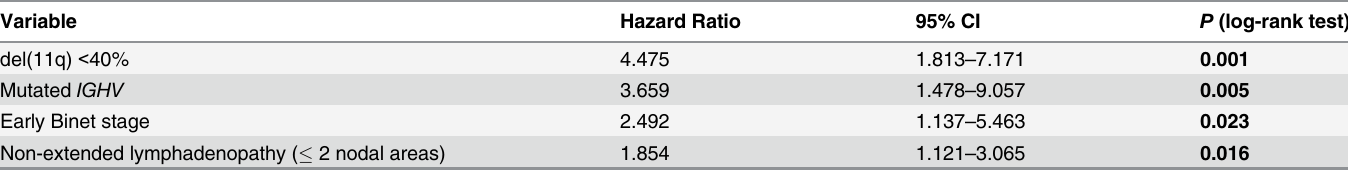
observed in patients with a low frequency of losses in 11q-. Thus, in patients with loss of 11q in (cid:1) 40% of cells, the OS was 90 months (95% CI, 57 – 123 months), while in the group with < 40% of losses in 11q, the median OS had not been reached (95% CI, 114 – 157 months) ( P = 0.006) (Fig 1B). In the univariate analysis, early clinical Binet stage ( P = 0.001), asymptomatic disease ( P = 0.034), absence of hepatomegaly ( P = 0.025) or splenomegaly ( P < 0.0001), lymphocyte count < 20 x 10 9 /L ( P = 0.032), low serum of either LDH level ( P < 0.0001) or β the presence of an association of 11q deletion and 13q deletion ( P = 0.045), and a low number ( < 40%) of cells with 11q- ( P = 0.006) were associated with longer OS (Table C in S1 File). In the multivariate analysis, the variables independently related to longer OS were the absence of splenomegaly (HR, 1.786; P = 0.023), low serum LDH (HR, 2.076; P = 0.018), low serum β (HR, 2.448; P = 0.006) and the presence of del(11q) in < 40% of cells (HR, 3.145; 95% CI, 1.474 – 6.691; P = 0.003) (Table 3). Regarding the patients with del(11q) as the unique cytogenetic aberration, a longer OS was observed in patients with 11q-L (median not reached vs 70 months, P = 0.007) The analyses of other cut-offs for the number of 11q- cells ( < 40% vs 40 – 59% vs (cid:1) 60%) showed similar results for TFT and OS (Fig B in S1 File).